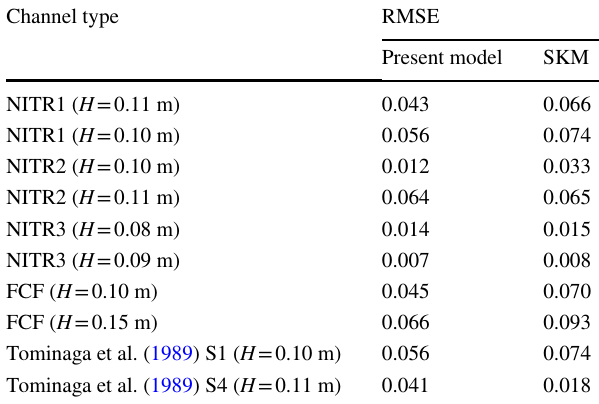
Table 2 RMSE results of depth-averaged velocity distribution by